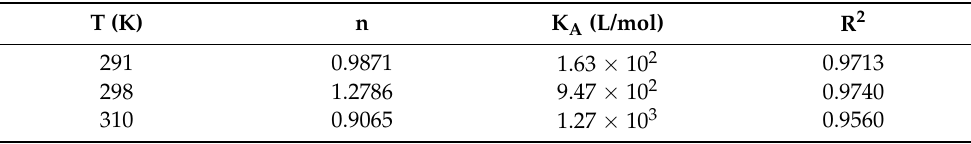
Table 2. Apparent binding constants (K A ), binding sites numbers (n), and determination coefficients (R 2 ) of EA and zein.